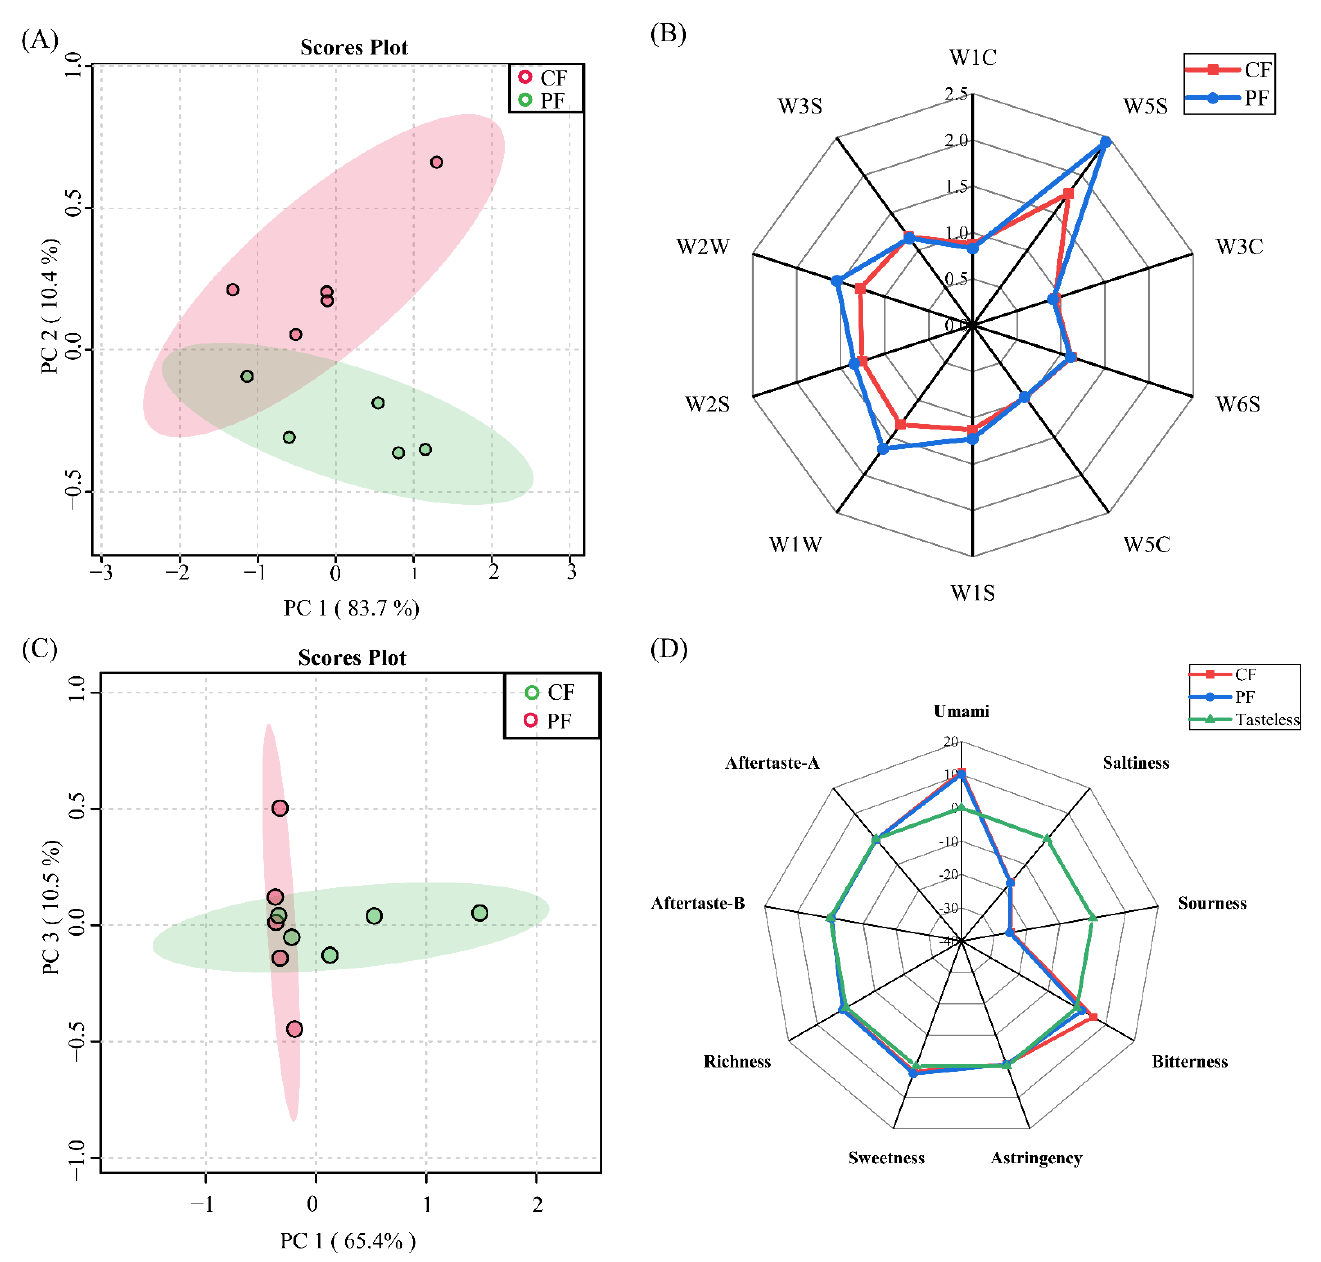
Figure 1. Aroma and taste profiles in concentrate-fed (CF) and pasture-fed (PF) groups ( n = 5). Prin- cipal component analysis score plots and radar charts of the E-nose response values ( A , B ) and the E-tongue taste values ( C , D